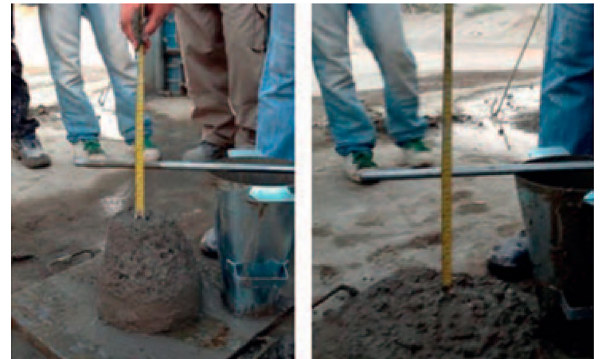
Figure 8. Photograph showing concrete slump